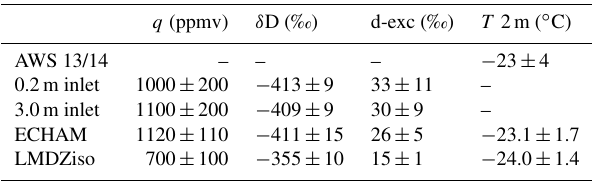
Table 3. Mean values over 29 daily averages from the measure- ment period (days with more than 8h of data gap have been re- moved). Uncertainties represent ± 1SD (standard deviation) of the mean value. ECHAM stands for